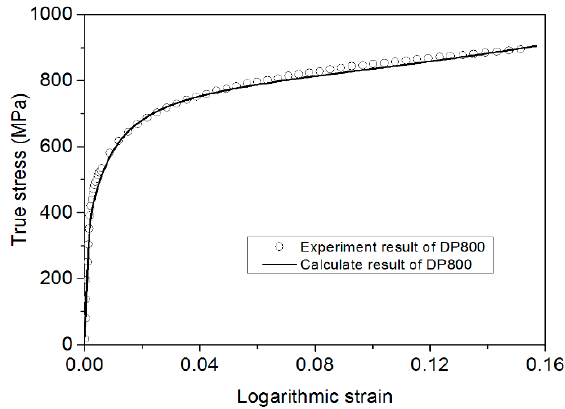
Figure 6. True stress vs. logarithmic strain curve from experiment and simulation.